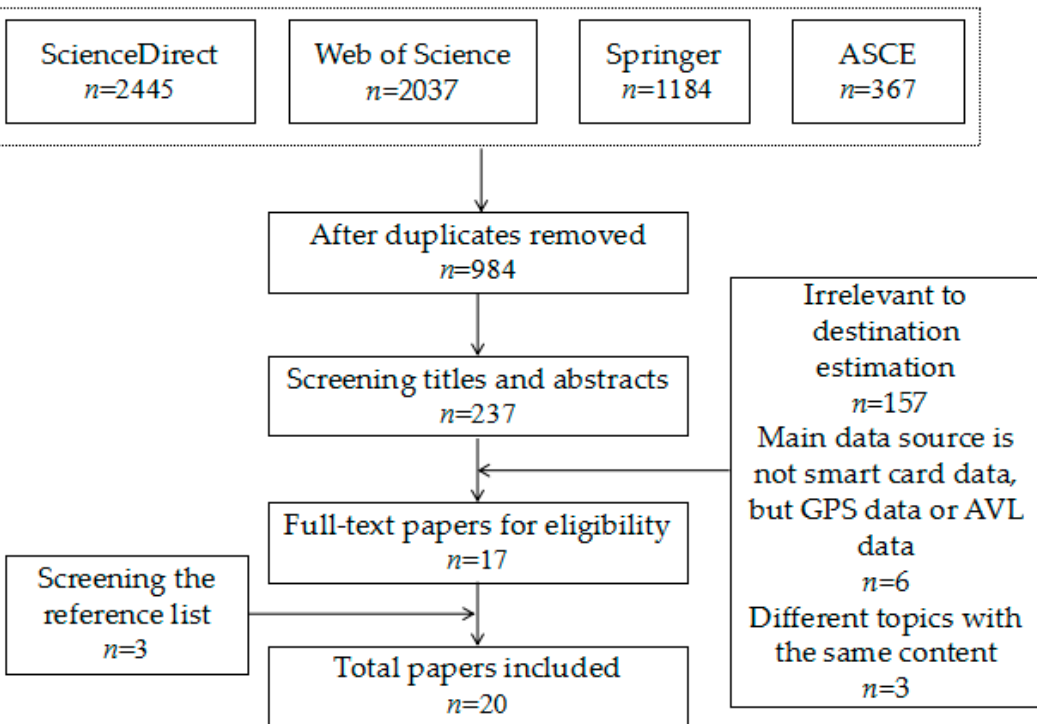
Figure 1. The literature search and selection process.